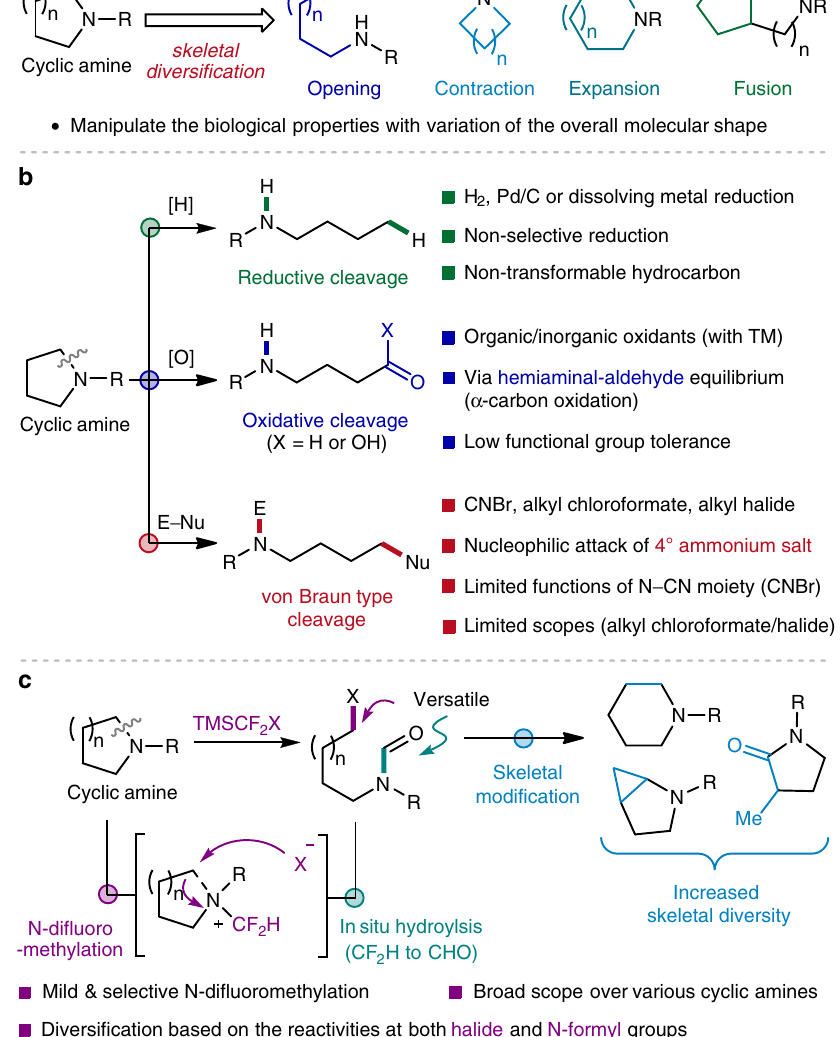
Fig. 1 C – N Bond cleavage of unstrained cyclic amines. a Importance of skeletal diversi fi cation of unstrained cyclic amines. b Previously reported strategies for C – N bond cleavage of cyclic amines. c This work: Ring-opening halogenation via N -di fl uoromethylative C – N bond